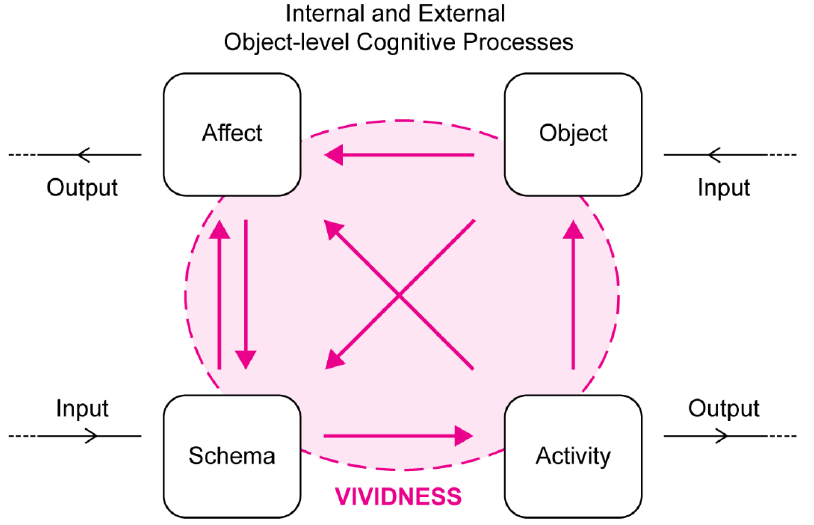
Figure 4. According to Marks [56], four key processes guide the conscious assessment of the surroundings—affect, schema, object, and activity. The cycle of activity triggers the formation of mental images of varying levels of vividness to help with the assessment of an observed external activity or with an internal goal. It is the degree of neuronal activation between those four key processes that determines the level of vividness of the perceived mental image, as well as the vividness of the sensations associated with it. Figure adapted from Marks [56].